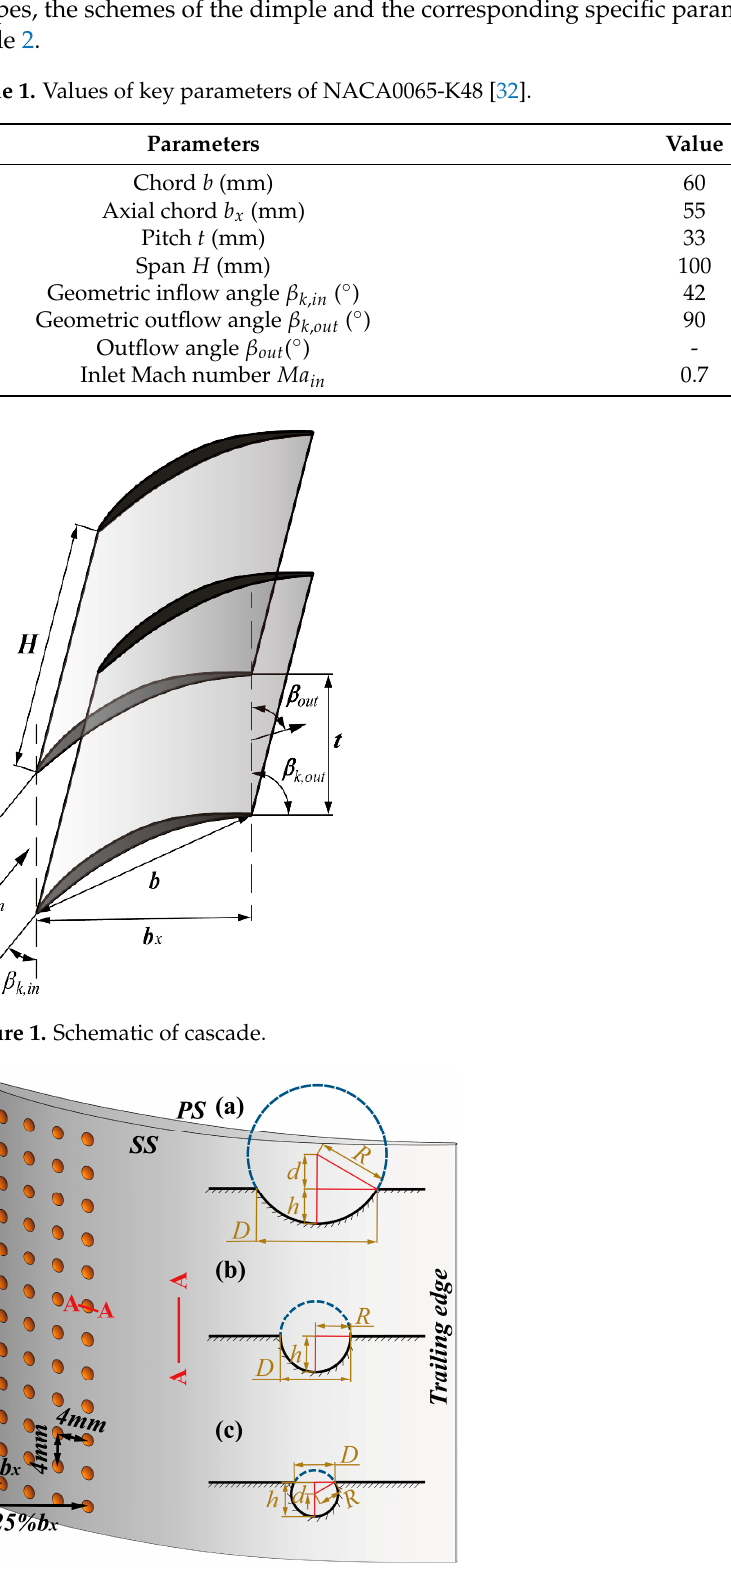
Figure 2. Schematic of dimples. ( a ) Inferior arc (INF); ( b ) semicircular arc (SEM); ( c ) superior arc